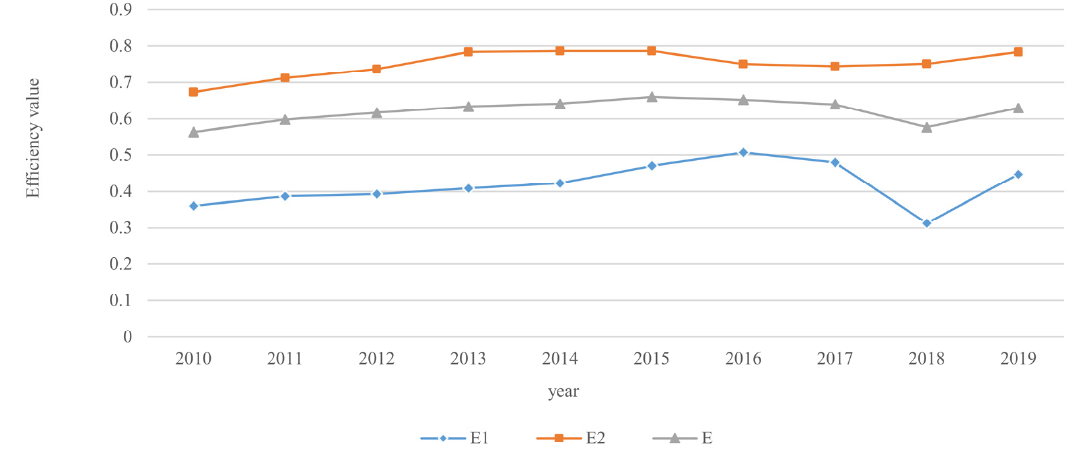
Figure 2. Line chart of innovation resource allocation efficiency. Nanjing metropolitan areas are more efficient, and the Yinchuan, Nanning, and